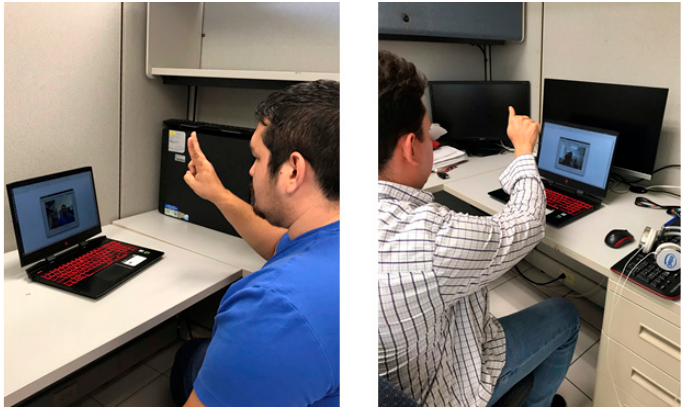
Figure 3. American Sign Language alphabet translator experiments environment. Three groups of user volunteers participated in the generation of the datasets and